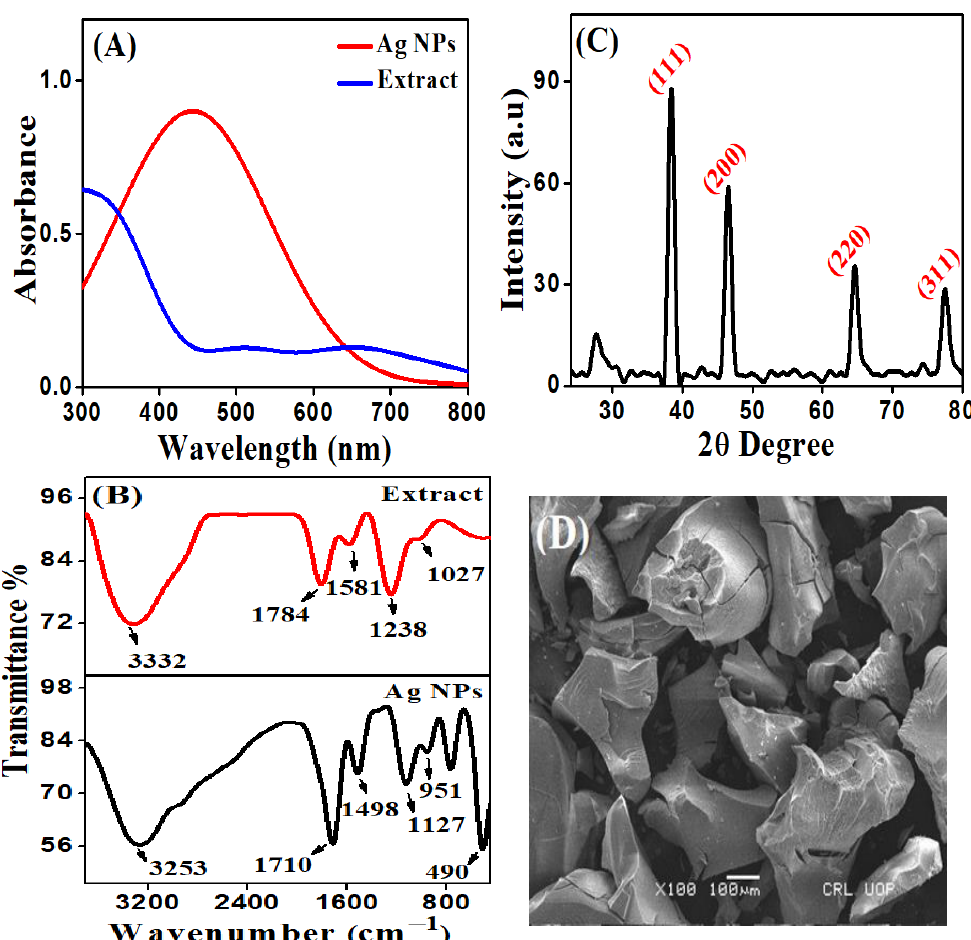
Figure 1. UV-visible spectroscopy of Ag NPs and Zingiber officinale plant extract ( A ), FT-IR spectra of synthesized Ag NPs and an aqueous plant extract of Zingiber officinale ( B ), XRD of Ag NPs synthesized by Zingiber officinale plant Extract ( C ), SEM image of Ag NPs under 100 µm ( D ).